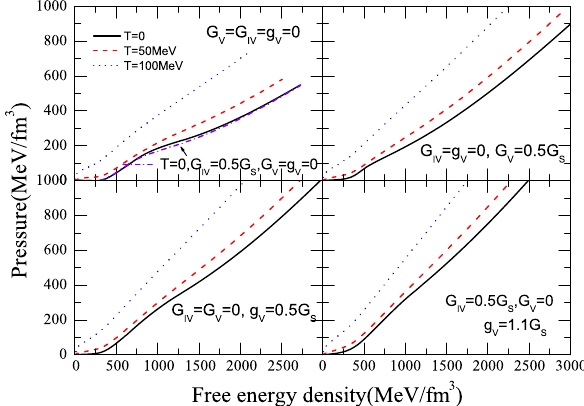
Fig. 4 Pressure as a function of free energy density for SQM within different vector interaction